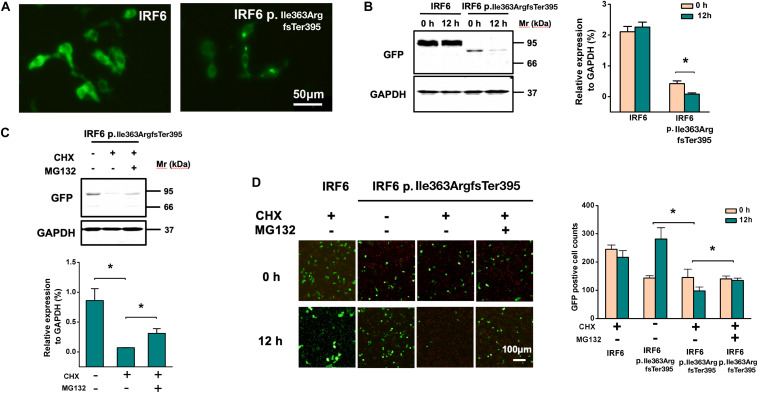
Frameshift of IRF6 at Ile363 causes its proteasome-dependent degradation. (A) Images of cells expressing IRF6 p.Ile363ArgfsTer395 under fluorescence presented much weaker GFP fluorescence, but several bright dots in cytoplasm, suggesting the existence of proteasome-dependent degradation. (B) Western blot of transfected HEK293FT cells lysis when treated at 36 h post-transfection with CHX. Over the 12-h time-course, no significant decline in WT IRF6 levels were observed but IRF6 p.Ile363ArgfsTer395 levels rapidly declined. The difference is significant (*P < 0.05). (C) Treated transfected HEK293FT cells with the proteasome inhibitor MG132 for 30 min prior to CHX addition. Western blot indicated that in cells treated with MG132, the loss of IRF6 p.Ile363ArgfsTer395 was attenuated modestly, the difference is significant (*P < 0.05). (D) GFP fluorescence observation of transfected HEK293FT cells when treated at 36 h post-transfection with CHX. Over the 12-h time-course, no significant decline in WT IRF6 levels were observed but IRF6 p.Ile363ArgfsTer395 levels rapidly declined. GFP fluorescence observed modestly attenuation when treated GFP-IRF6 p.Ile363ArgfsTer395 plasmid transfected HEK293FT cells with the proteasome inhibitor MG132 for 30 min prior to CHX addition (*P < 0.05).